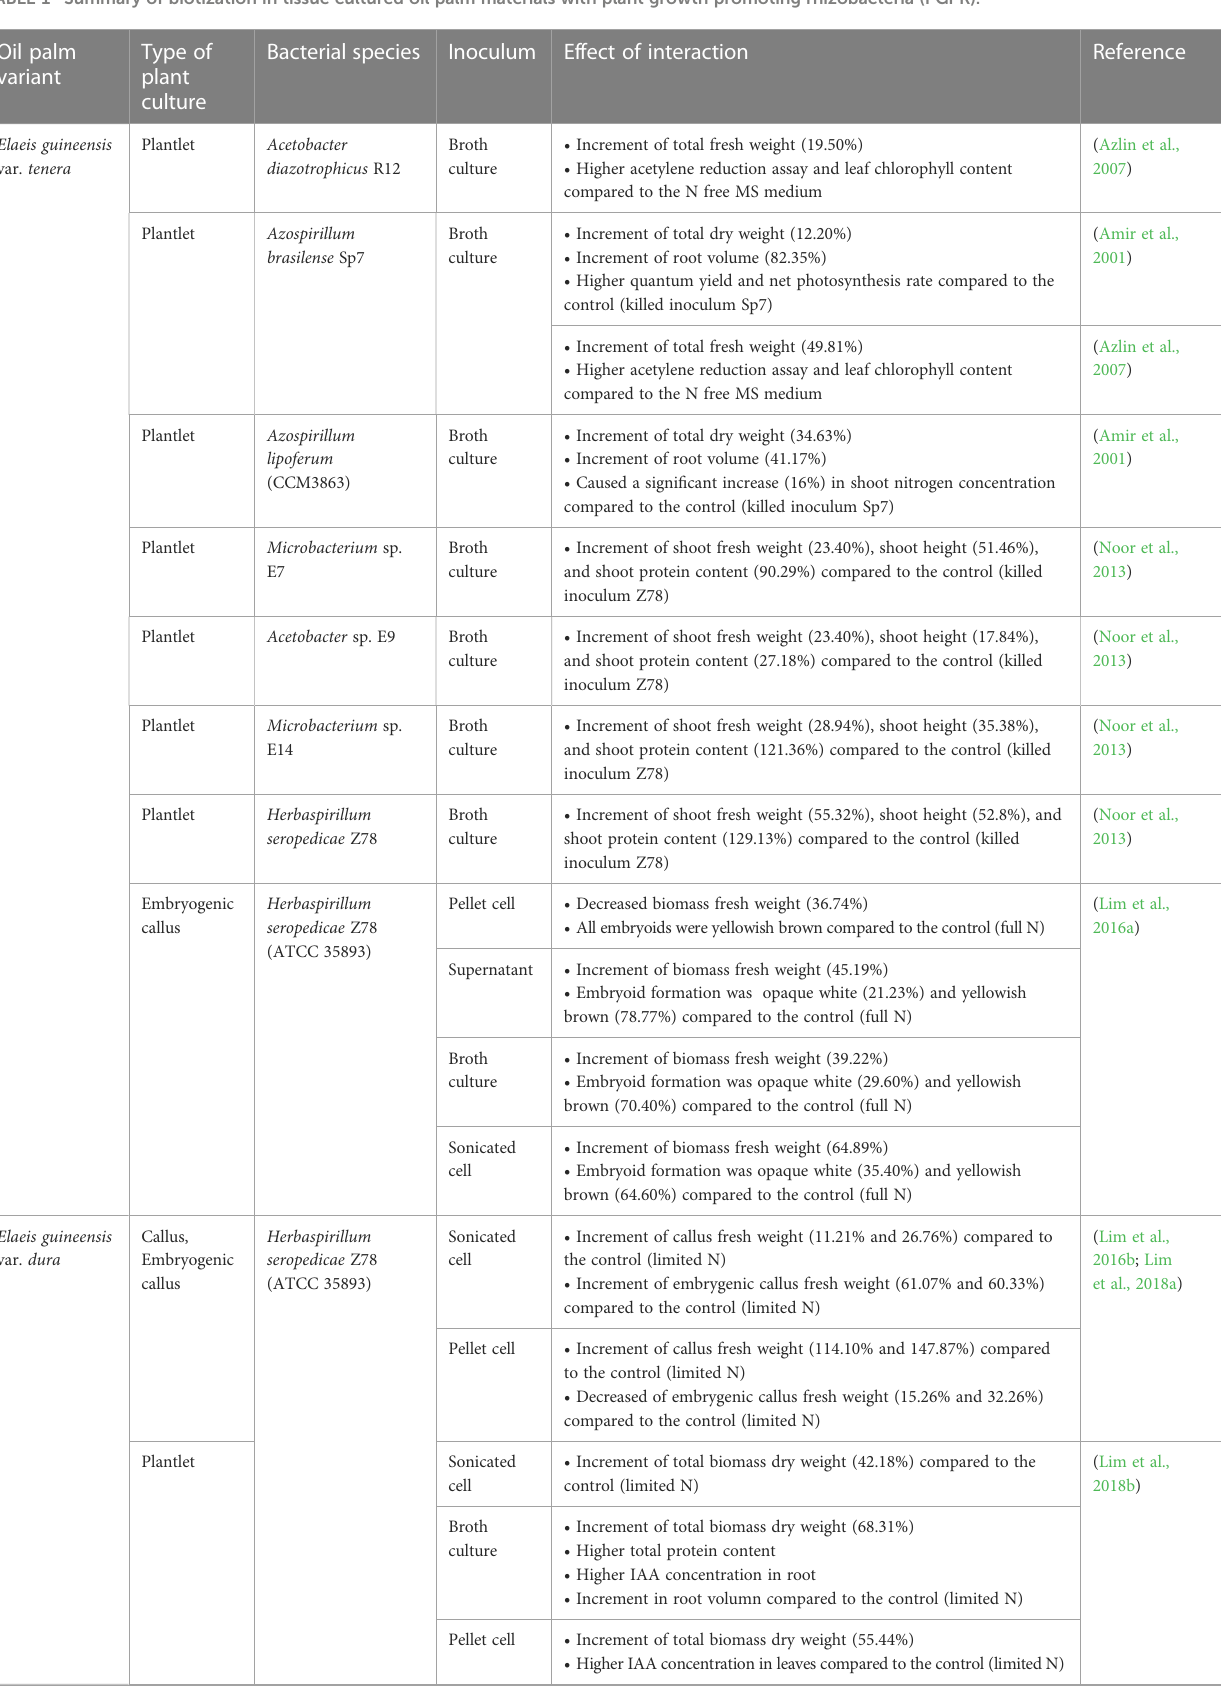
TABLE 1 Summary of biotization in tissue cultured oil palm materials with plant growth promoting rhizobacteria